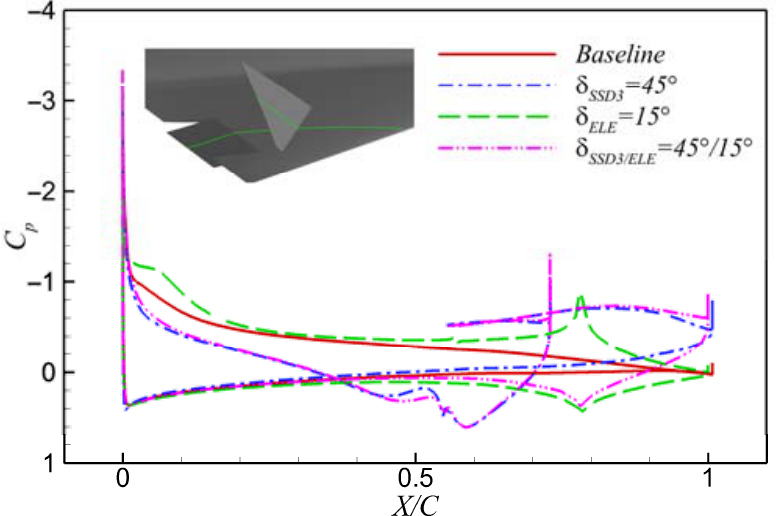
Figure 13. C p distribution for the sections of four configurations, Ma = 0.2, Re = 3.98 × 10 7 , α = 6°.